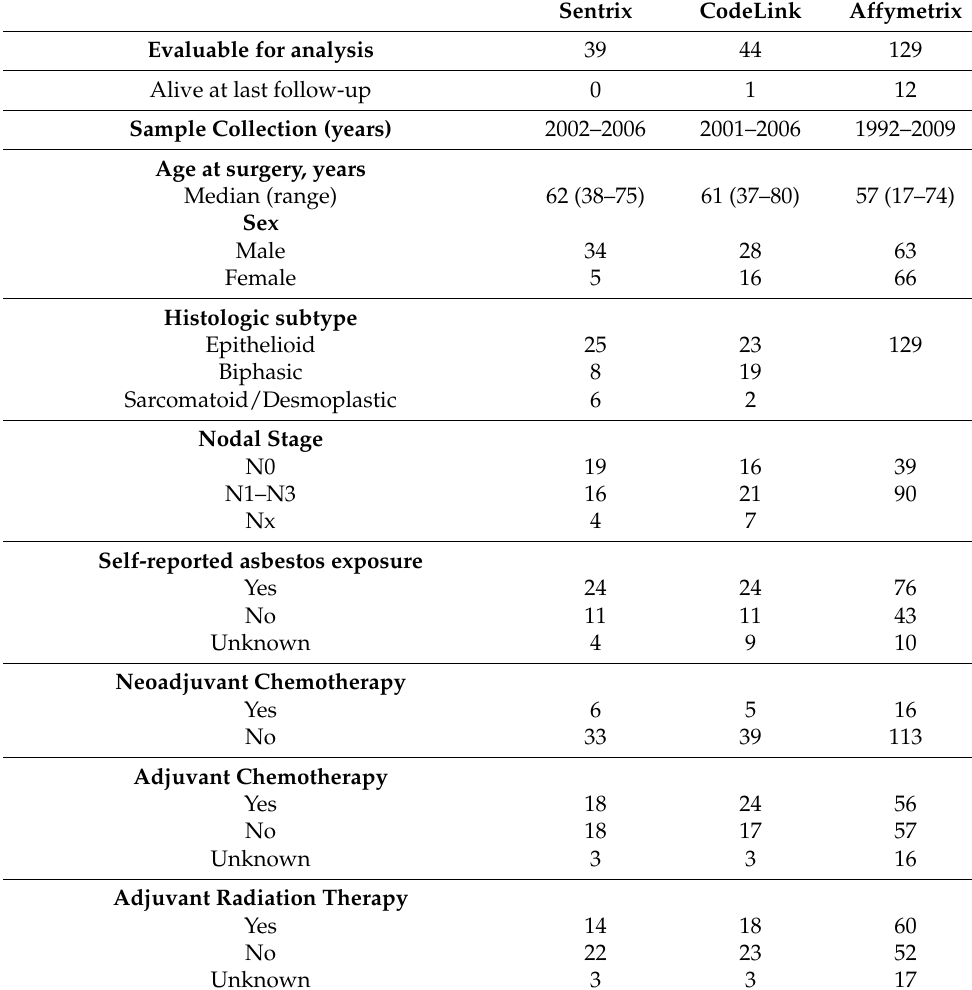
Table 2. Clinical and histopathologic characteristics of epithelioid